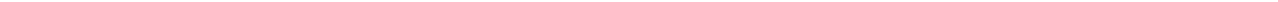
Fig. 1 Immunogenicity of CH505 Envelopes in macaques. Rhesus macaques were immunized with CH505 transmitted-founder (TF) or natural variants of TF (weeks (w) 53, 78, and 100) envelope (Env) alone, or sequential combinations of TF and TF − variants in AS01E or GLA-SE adjuvants. Immunization time points are indicated by an arrow. a , b Neutralization pro fi les of plasma post sixth immunization from macaques immunized with CH505 Envs in AS01E ( a ) or GLA-SE ( b ). Neutralization was assessed in TZM-bl cells once, except for titers < 100 ID50 that are representative of two independent assays. c Post- sixth immunization plasma autologous neutralization titers. Each symbol represents the neutralization titer per animal, and the neutralization titers per group of animals are shown via box and whisker plots; box indicates median, and lower and upper quartile ranges, and whiskers indicate minimum and maximum titers. Neutralization positivity cutoff was 20 ID50 (dotted line). P = 0.07, exact Wilcoxon test; CH505.w4.3 neutralization titers for macaques immunized with CH505 TF alone or sequential Envs in AS01E. P = 0.3, Kruskal – Wallis test; CH505.w4.3 neutralization titers for macaques immunized with all CH505 Env regimens in GLA-SE. P = 0.8, exact Wilcoxon test; plasma neutralization titers for macaques immunized with CH505 TF Env in AS01E or GLA-SE. P = 0.4, exact Wilcoxon test; plasma neutralization titers from macaques immunized with sequential CH505 Envs in AS01E or GLA-SE. d , e Vaccination peaks and troughs for plasma reactivity with CH505 TF Env gp120; macaques were immunized with CH505 TF Env in AS01E or GLA-SE ( d ), and CH505 sequential Envs in AS01E or GLA-SE ( e ). Binding was performed in a single ELISA, each symbol represents plasma binding per animal, and the best fi t line represents mean plasma binding within each group of animals. P < 0.05 is signi fi cant (exact Wilcoxon test); post sixth immunization, CH505 TF gp120 plasma-binding titers in macaques immunized with CH505 TF in AS01E (9.3 ± 1.0) or GLA-SE (8.9 ± 1.6) ( P = 0.8) ( d ) and sequential CH505 Envs in AS01E (10.2 ± 0.9) or GLA-SE (10.0 ± 0.8) ( P = 0.7) ( e ). f , g Plasma, post sixth immunization, competitive inhibition of soluble CD4 and CD4- binding site broadly neutralizing antibody (bnAb) CH106 in ELISA. Each symbol represents blocking levels per animal and the best fi t line represents the mean blocking activity within each group of animals. Shown are representative plasma blocking activities of sCD4 and CH106 from macaques immunized with CH505 TF alone or sequential Env combinations (sequential,